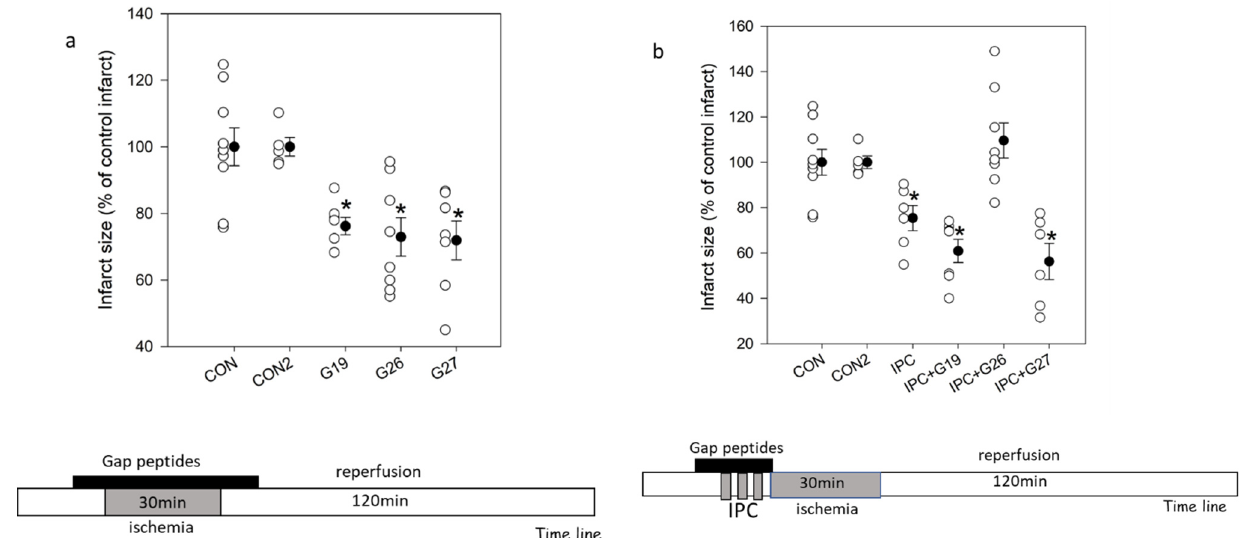
Figure 1. Infarct size in % of untreated control infarcts. Isolated buffer perfused hearts were subjected to global ischemia followed by reperfusion. Infarct size relative to the total ventricular volume was measured and results expressed in % of untreated control infarcts. ( a ) Controls subjected to ischemia-reperfusion with no treatment and hearts treated with Gap19, Gap 26 or Gap 27 (0.05 µM) before ischemia initially at reperfusion. ( b ) Hearts subjected to ischemic preconditioning IPC prior to 30 min ischemia-reperfusion with no treatment or with Gap19, Gap 26 or Gap 27 (0.05 µM) added to the buffer only during the PC treatment. Open symbols represent individual hearts, closed symbols are group mean ± SEM, * p < 0.05 vs.